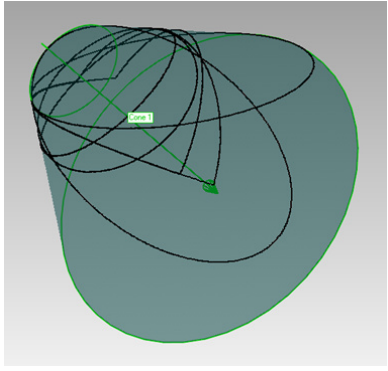
Figure 8. Final cone with points in planes